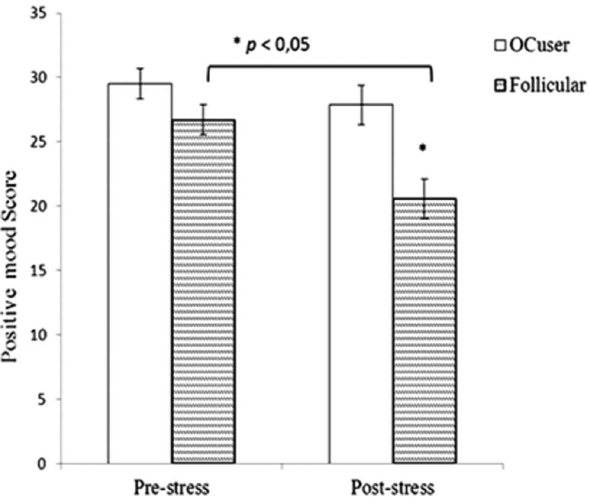
Fig. 2. Mean values ¡ SEM of positive mood scores during the stress condition by group (* p , .01).